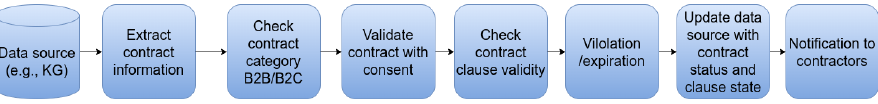
Figure 3. A general overview of CCV